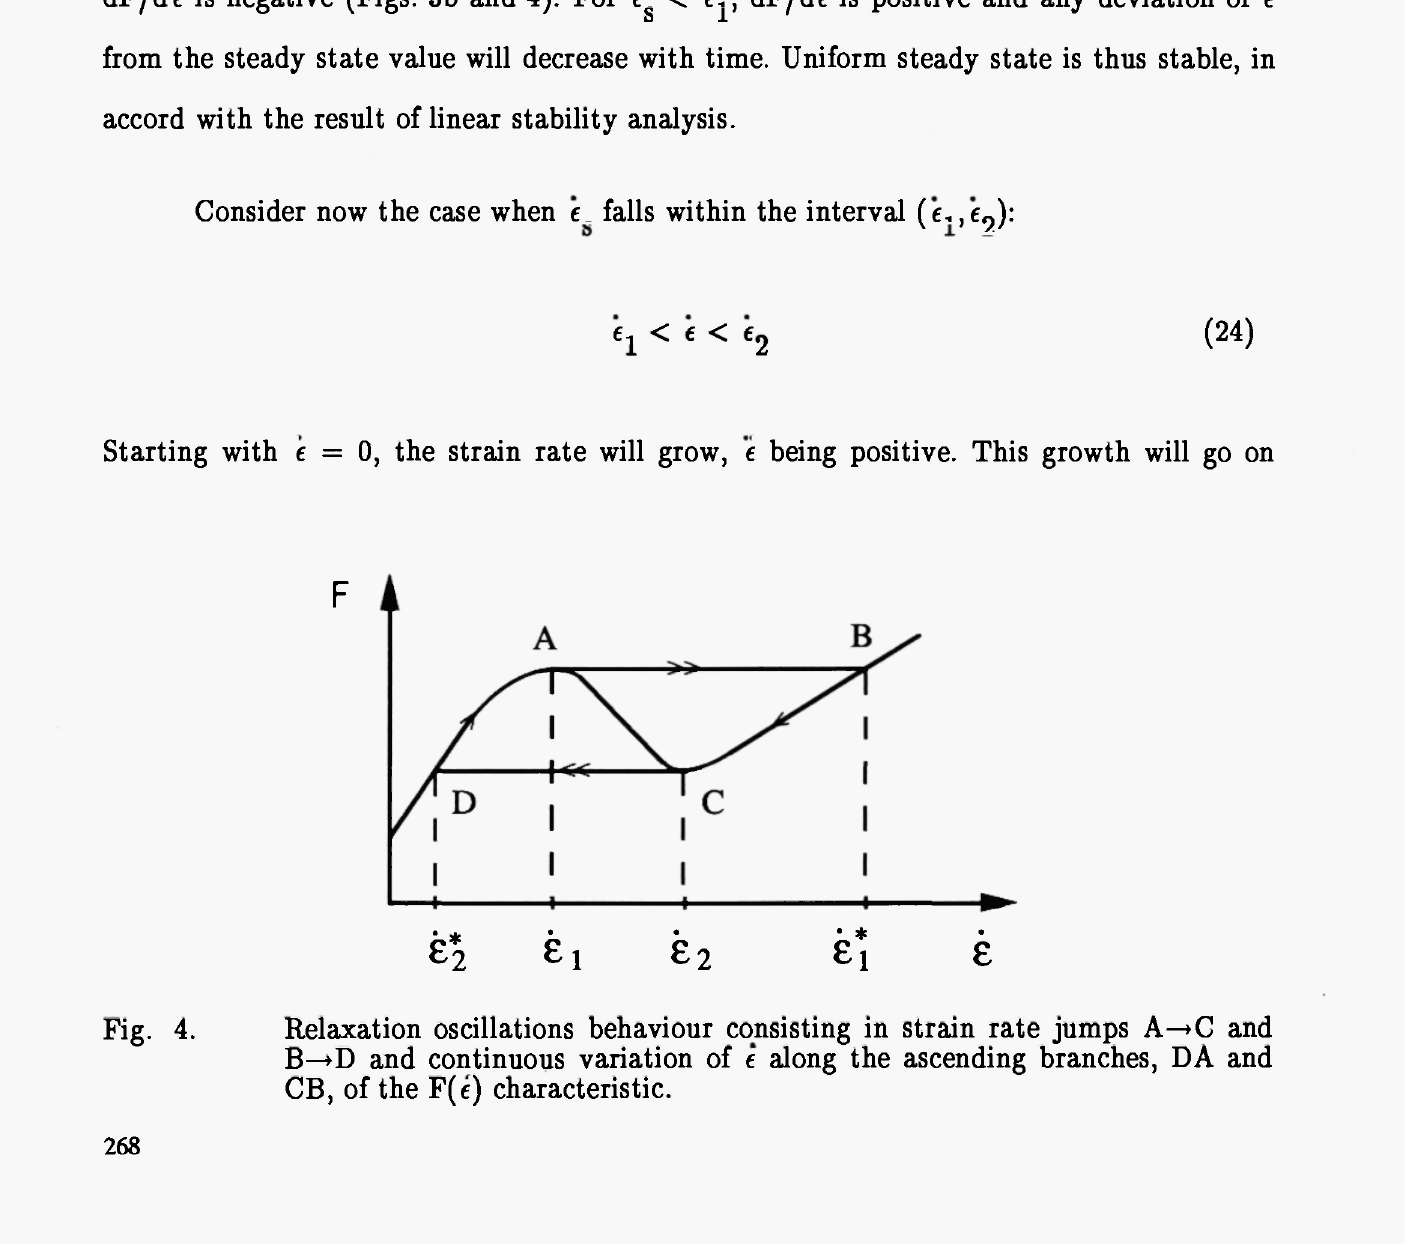
Fig. 4. Relaxation oscillations behaviour consisting in strain rate jumps A—>C and B—»D and continuous variation of e along the ascending branches, DA and CB, of the F(e)